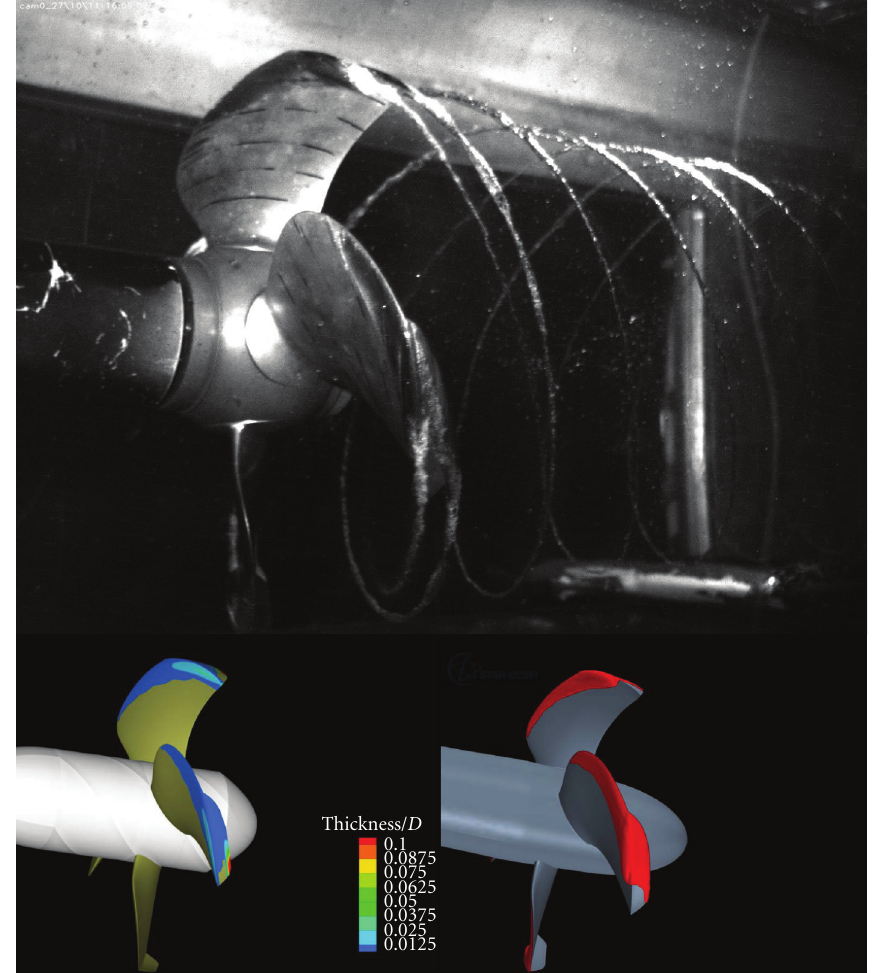
Figure 21: Cavity extension for open water KT equal to 0.213, at cavitation index of 1.625. Comparison with panel and RANSE numerical